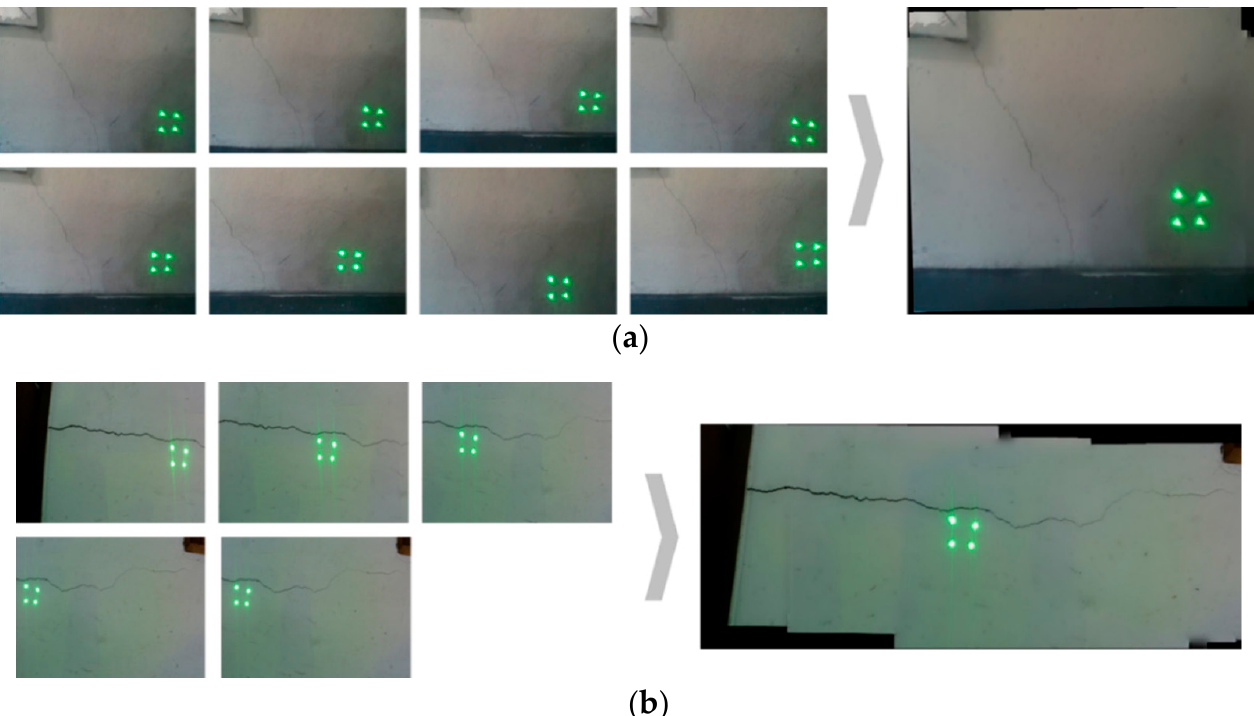
Figure 9. Image integration using the stitching algorithm. The captured images including ( a ) shear and ( b ) settlement cracks, and the merged image after performing homography calculation and image stitching. Table 2. Quantification results using integrated crack images.